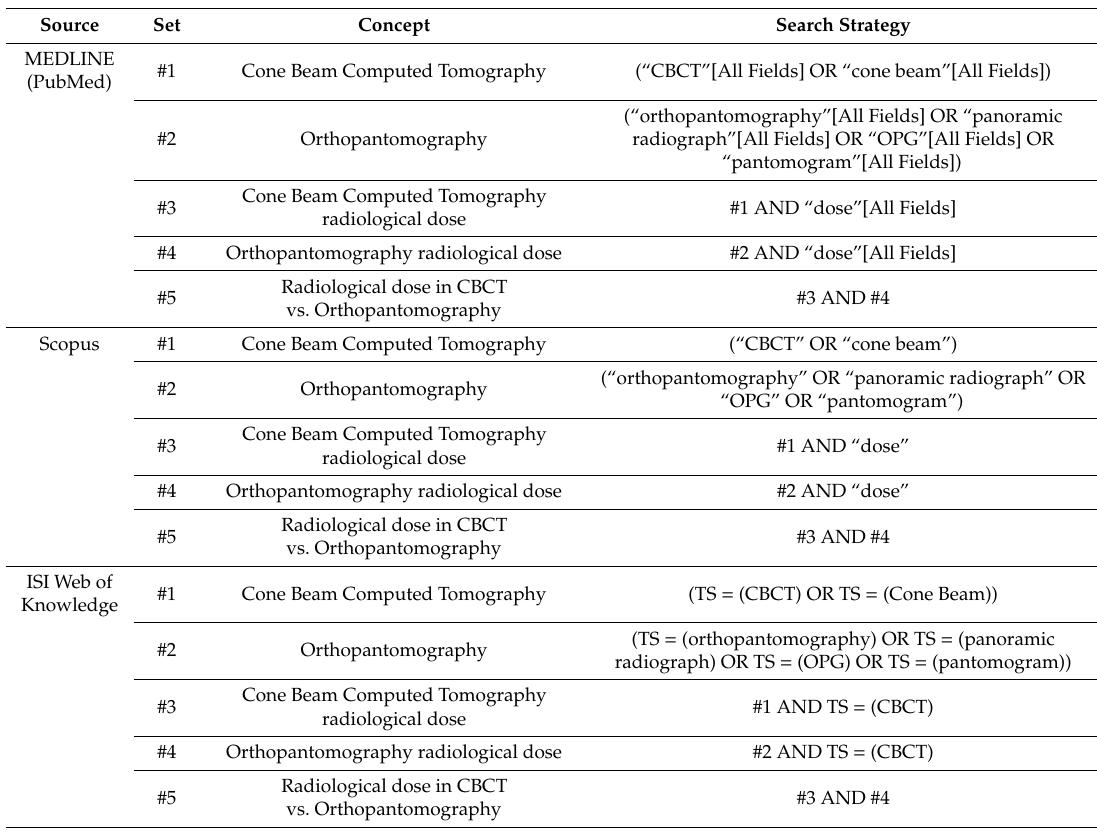
Table 3. Search strategy for articles comparing CBCT vs. OPG in terms of the radiation